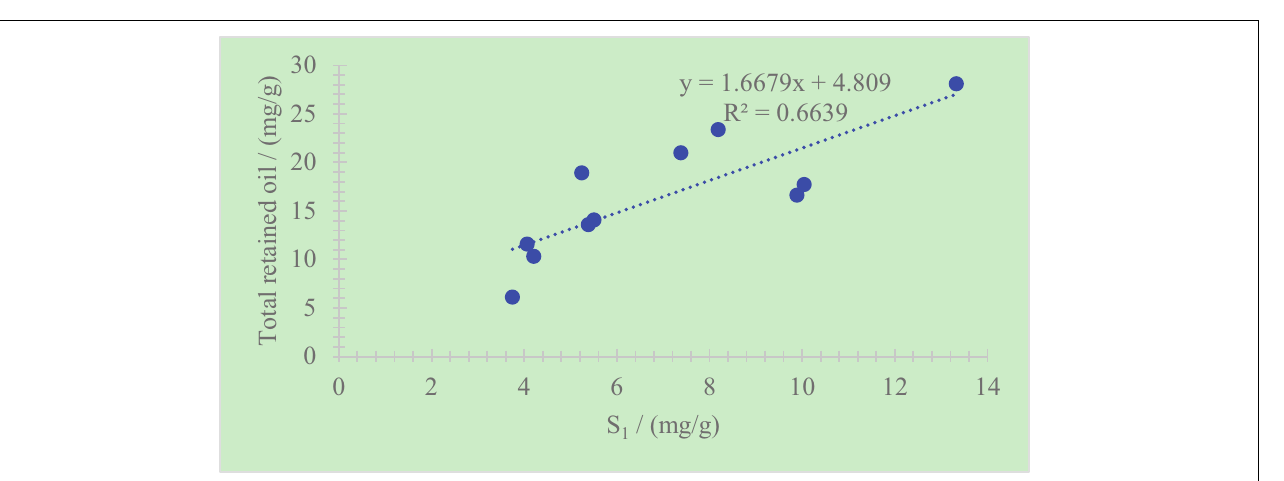
FIGURE 10 | Relationship between the total retained oil content and S 1